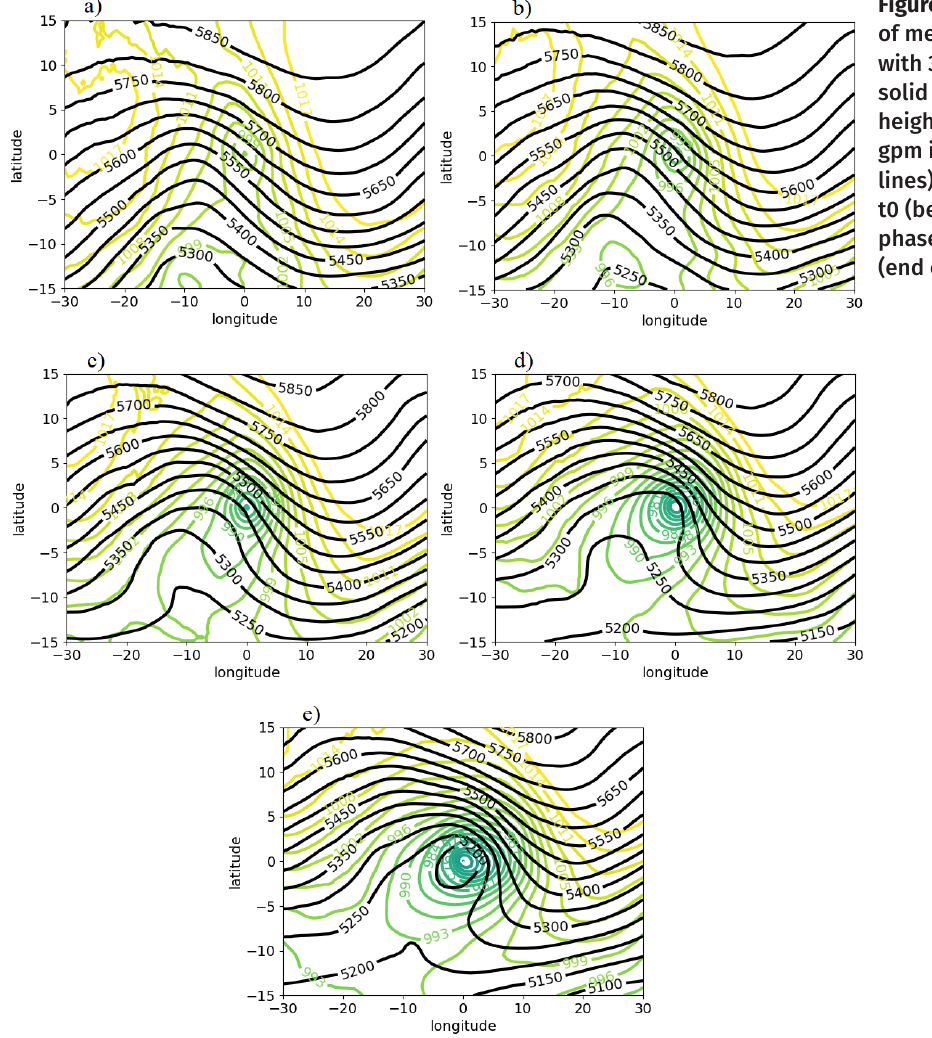
Figure 5. Composite fields of mean sea level